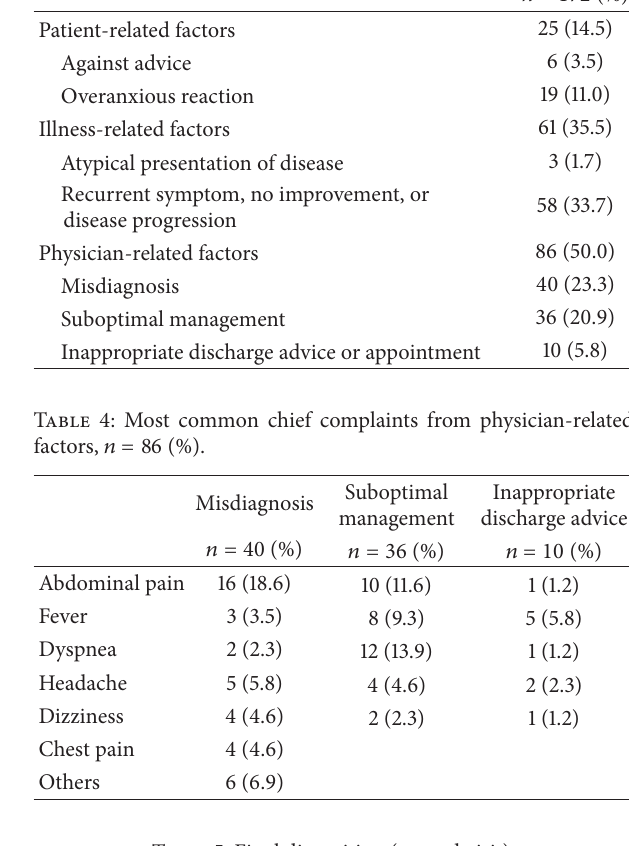
Table 5: Final disposition (second